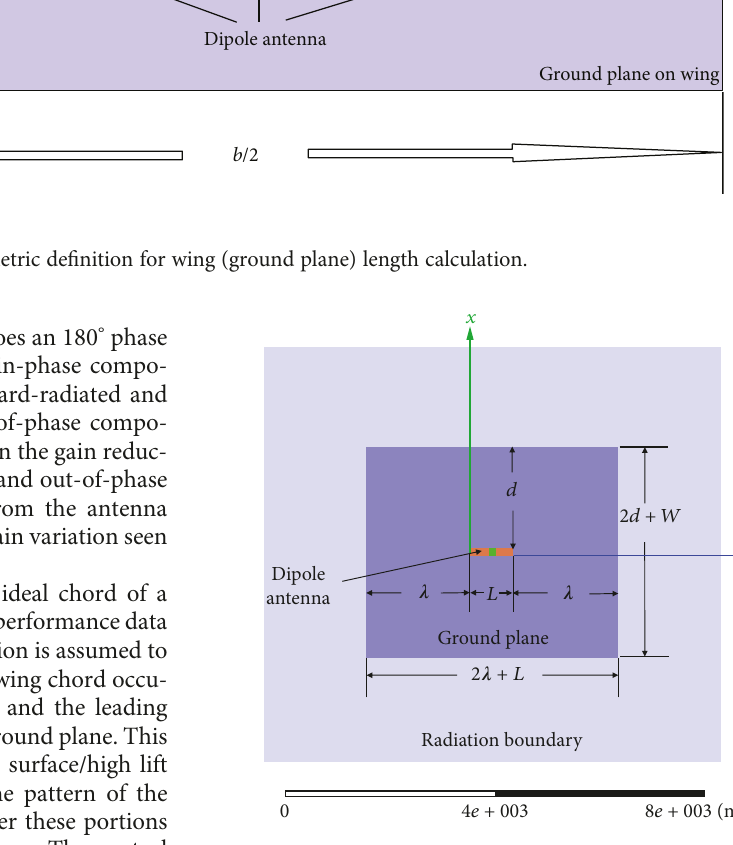
Figure 9: Simulation setup for the wing chord